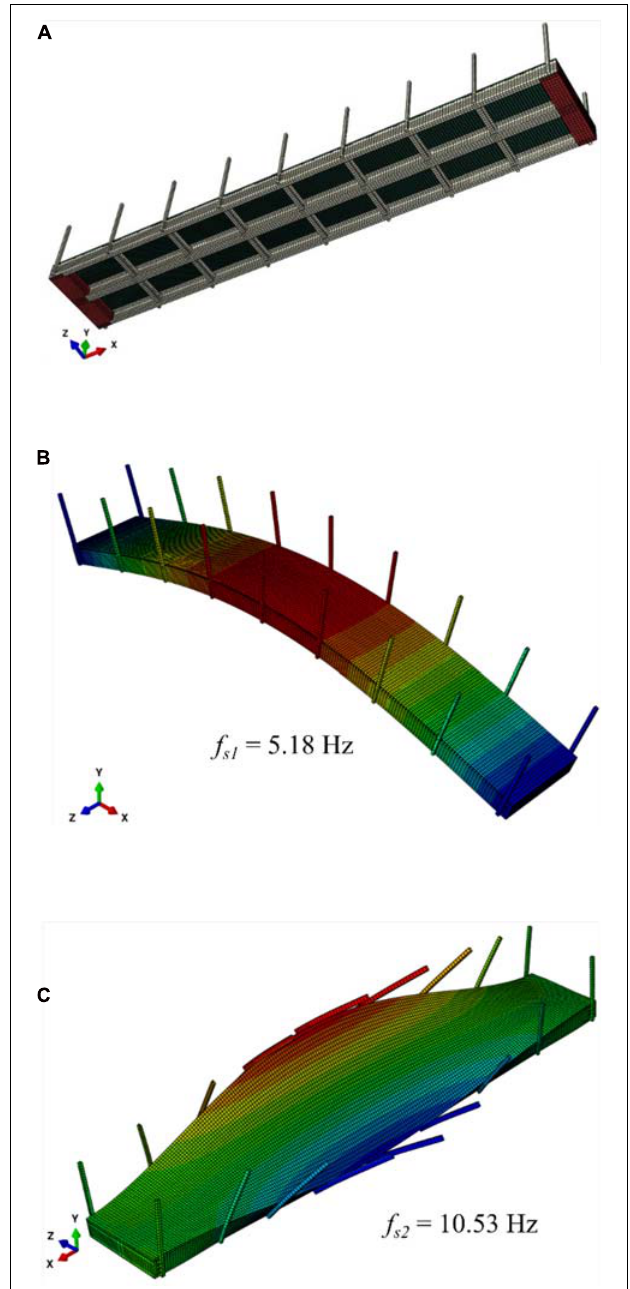
FIGURE 5 | Pedestrian bridge: (A) FE model, (B) First vibration mode, and (C) Second vibration mode.